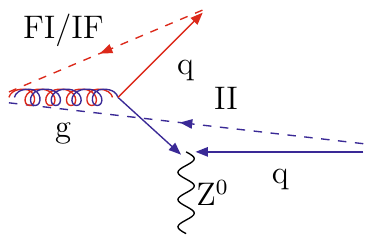
Fig. 10 Colour flow for the process q + g → γ ∗ / Z 0 + q. The dashed lines represent the colour lines stretched between the dipole